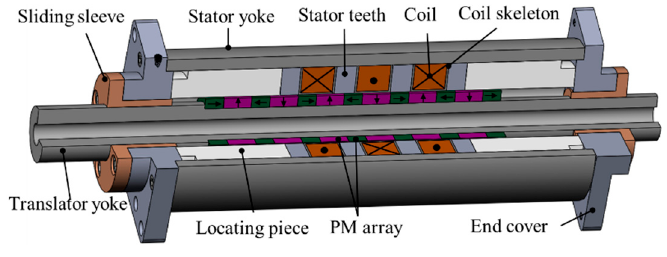
Figure 1. PMLG’s structure.